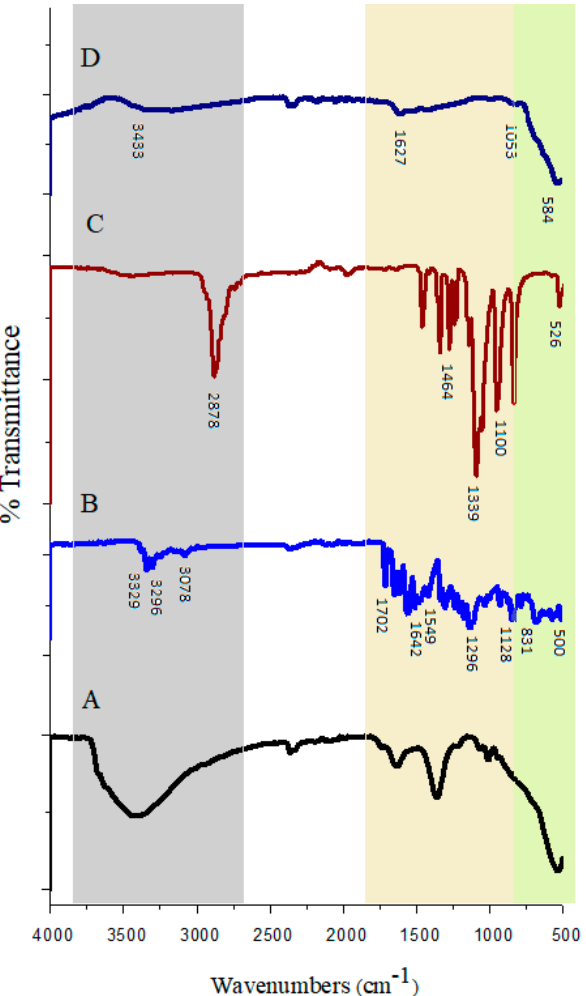
Figure 2. FTIR spectra for ( A ) Fe 3 O 4 @ − PEG-SFB; ( B ) SFB; ( C ) pure PEG; ( D ) Fe 3 O 4 nanoparticles.